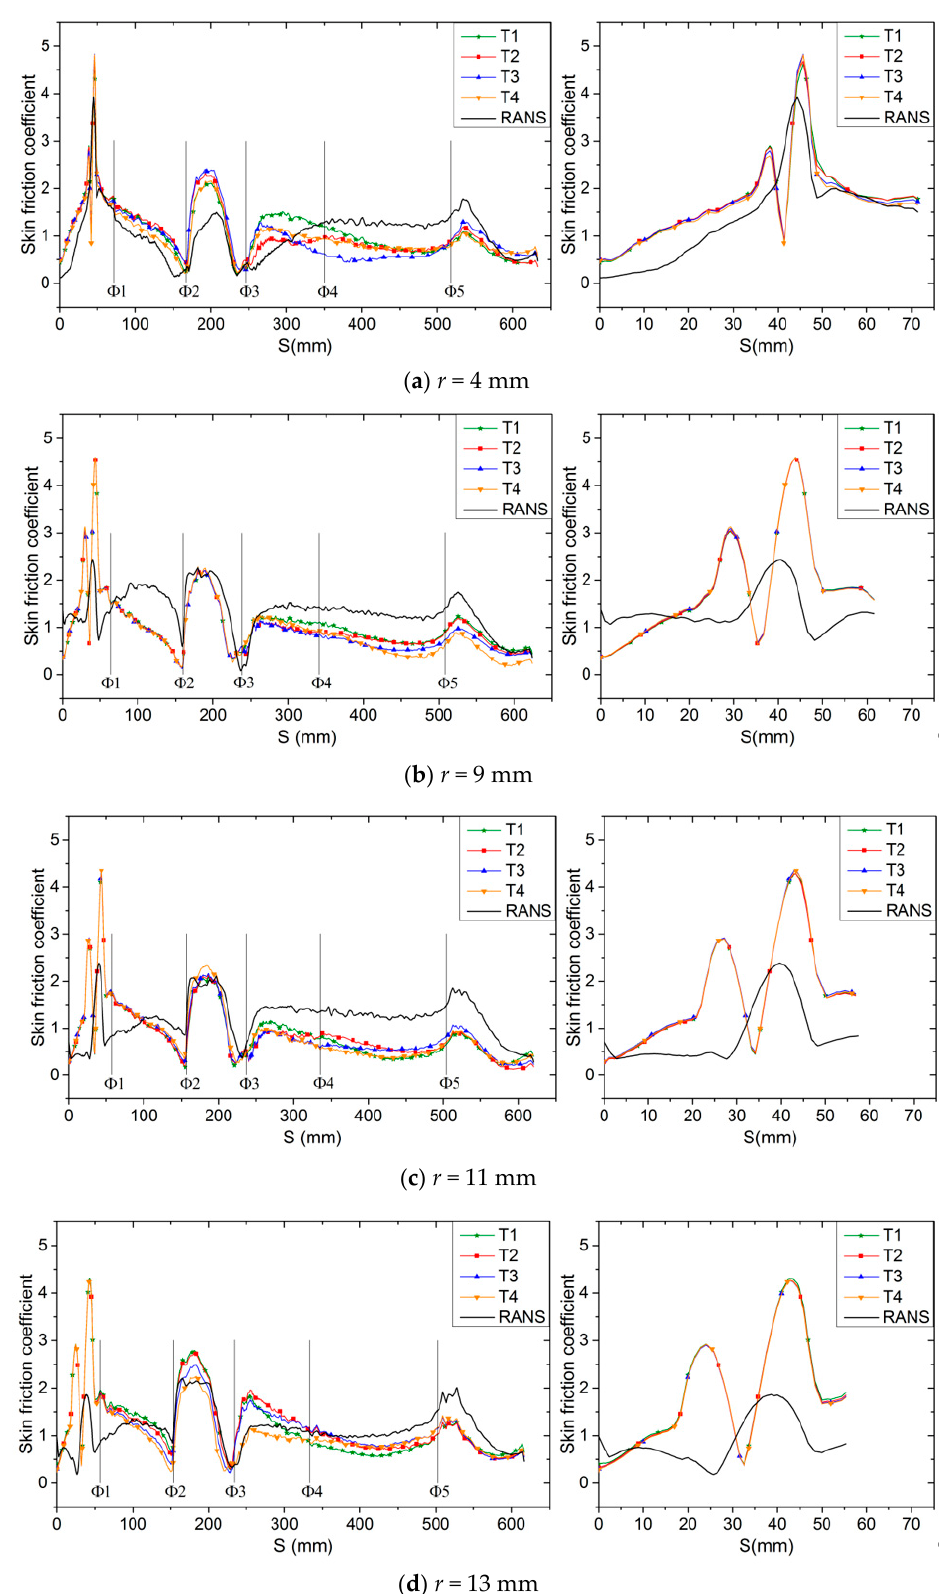
Figure 16. Distribution of skin friction coefficient around the volute surface (left column) and the enlarged view around the volute tongue (right column) on the Z = 4 mm cross-section.